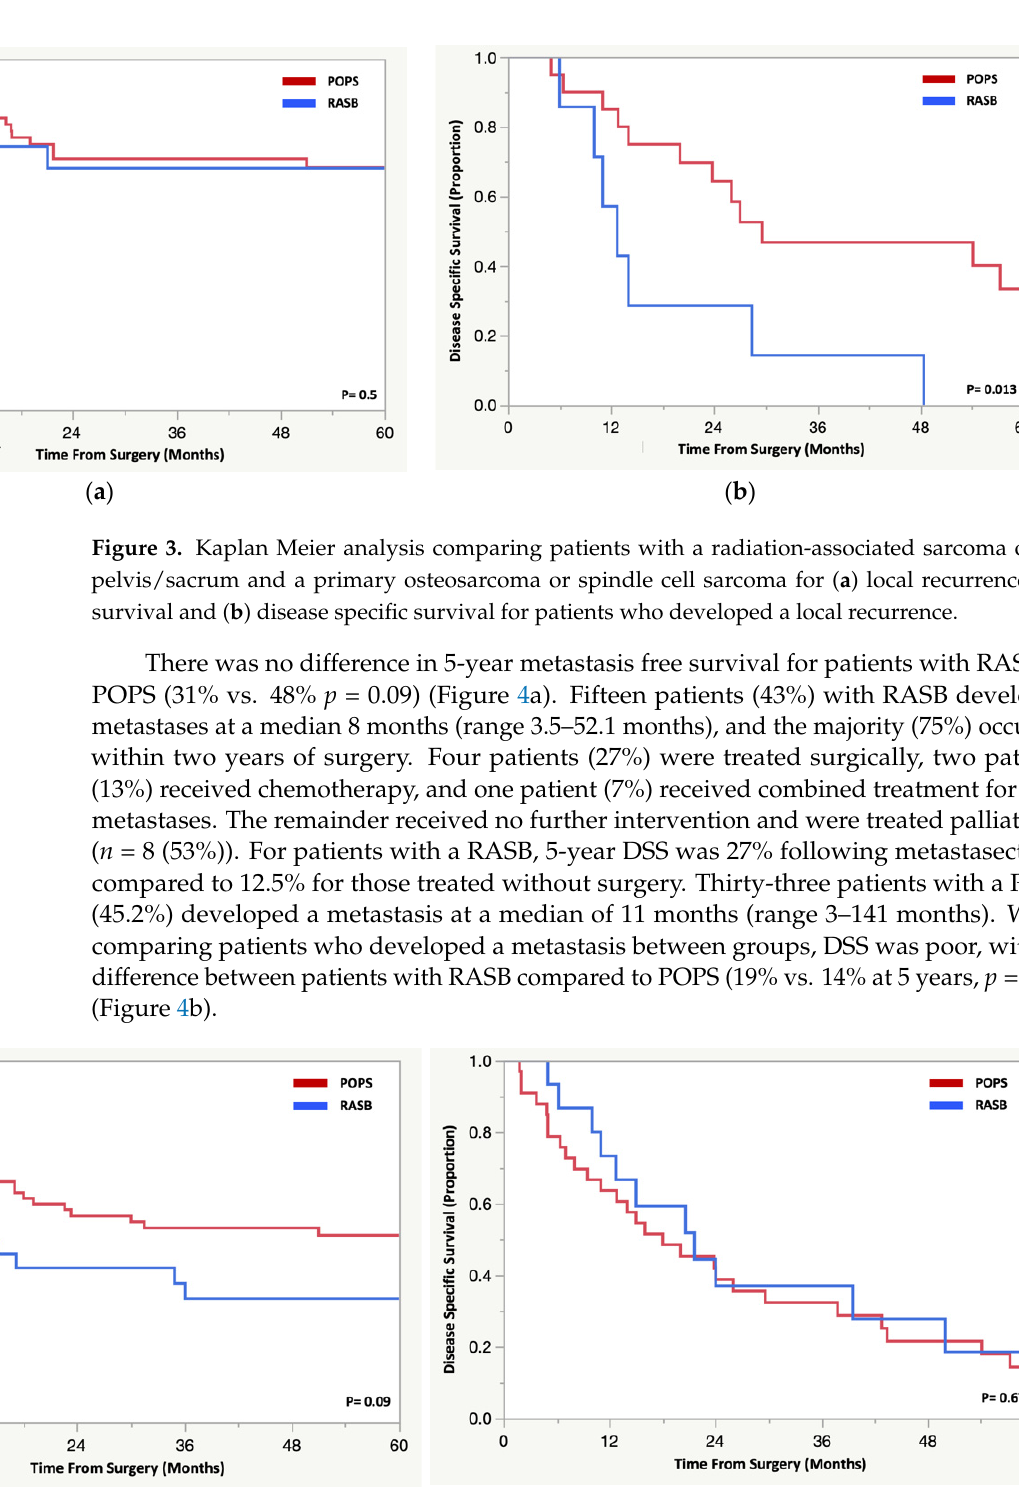
Figure 4. Kaplan Meier analysis comparing patients with a radiation-associated sarcoma of the pelvis/sacrum and a primary osteosarcoma or spindle cell sarcoma for ( a ) metastasis free survival and ( b ) disease specific survival for patients who developed a metastasis.